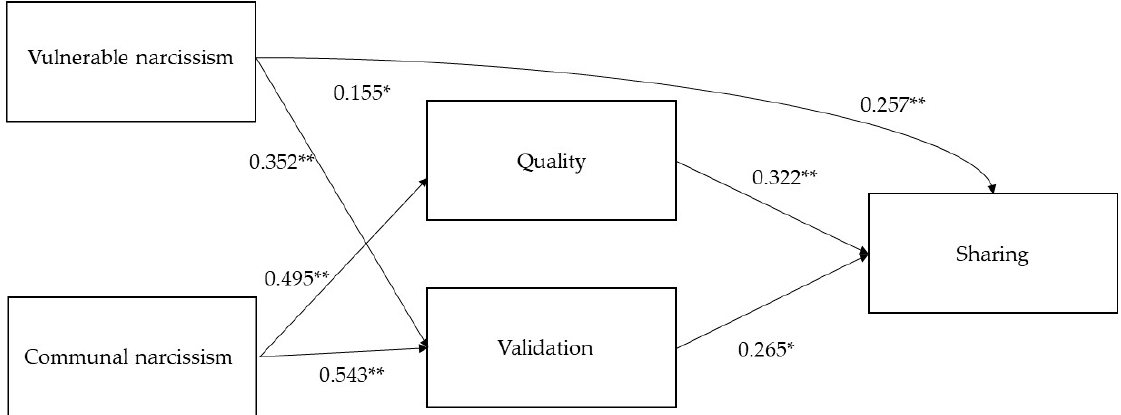
Figure 2. Final model of the relationship between narcissism and social media behaviors and motives. * Significant at the 5% level; ** significant at the 1% level.